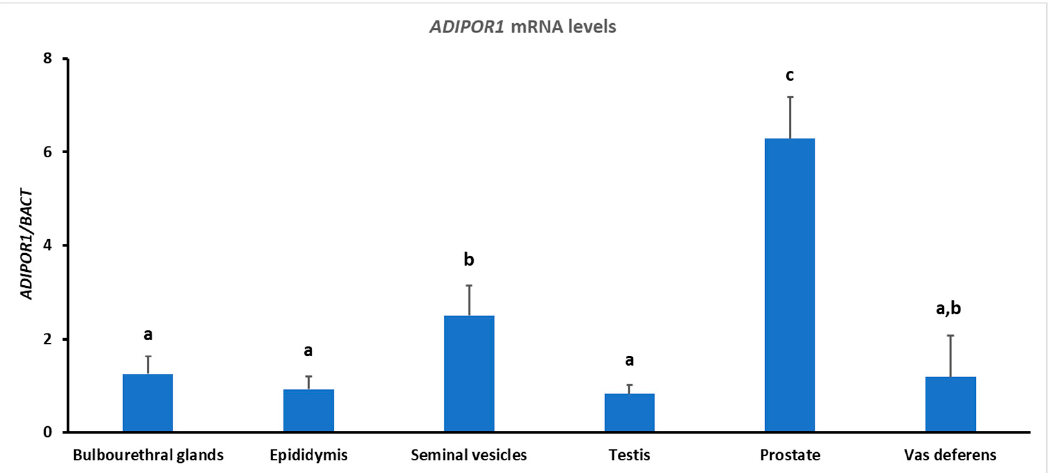
Figure 3. RT-qPCR analysis of ADIPOR1 gene expressions performed on adult ram male reproductive tissues. Different letters above bars indicate significantly different values (ANOVA p < 0.001, Levene’s test p > 0.05).